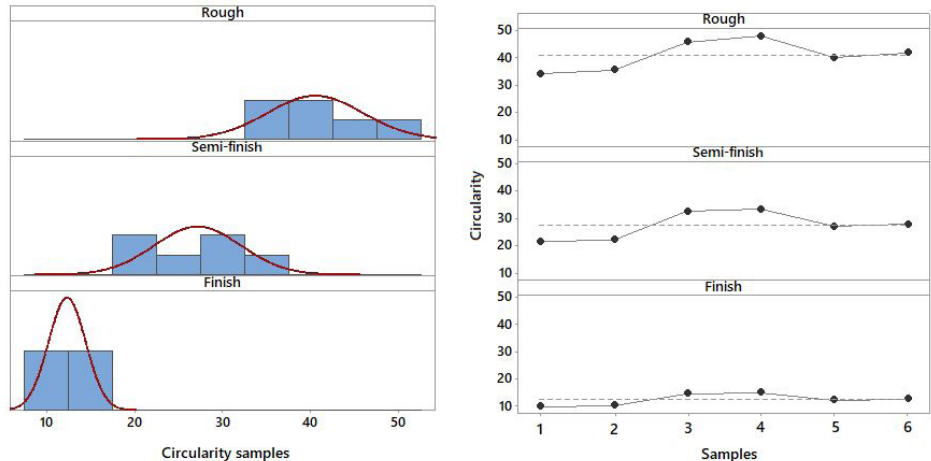
= 37 A, t = 180 µs), semi-finish (i e e